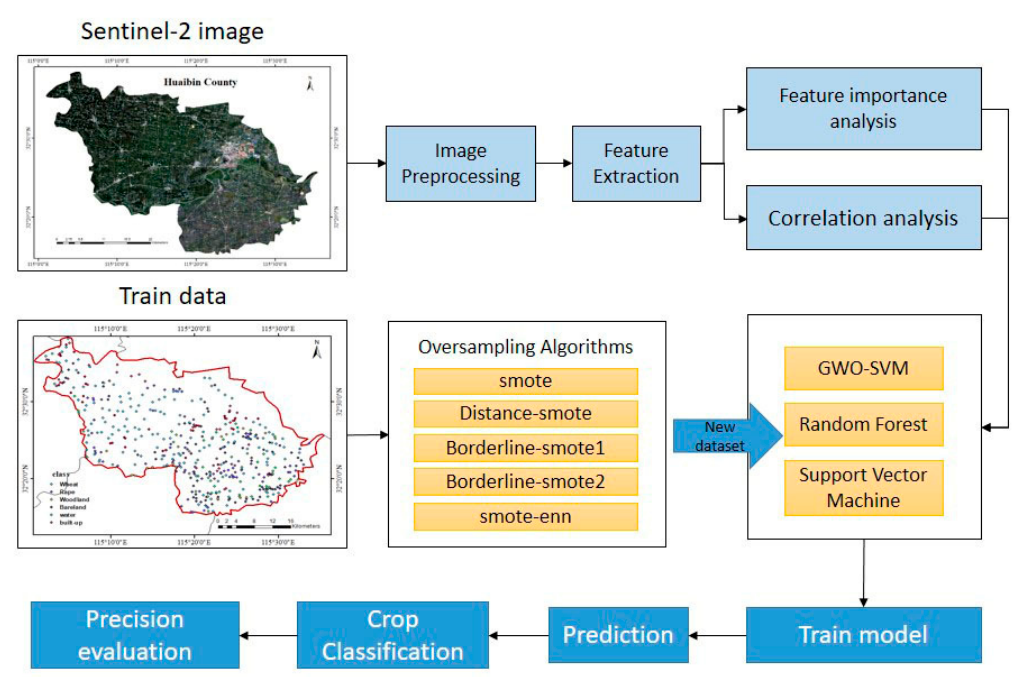
Figure 4. The flowchart of GWO-SVM model improved by smote oversampling technique in the crop mapping.